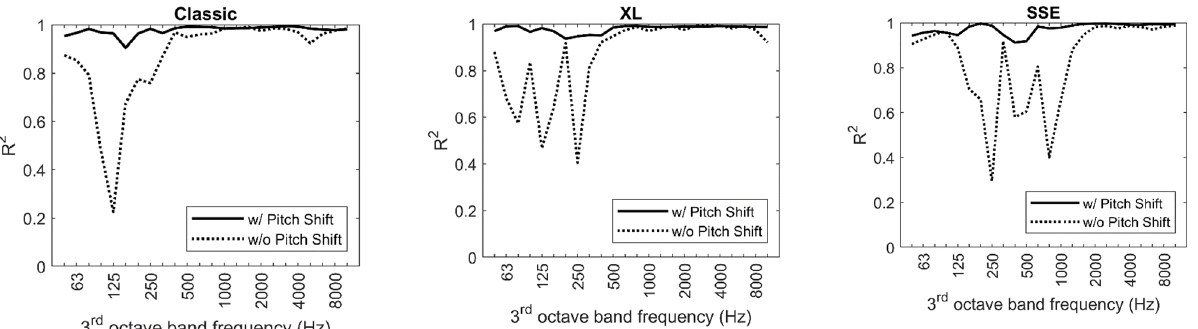
Figure 5. Coefficient of determination R 2 of source models for the three multicopters under evaluation, determined with and without pitch shift.